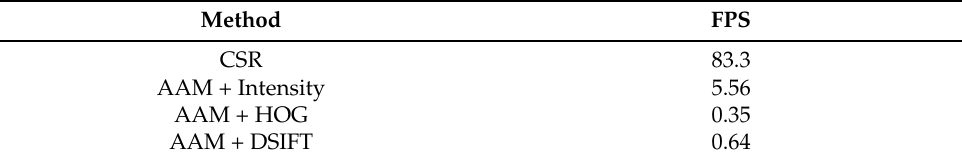
Figure 8. Examples of face alignment using Cascaded Shape Regression (CSR) and Intensity, Dense Scale Invariant Feature Transform (DSIFT), and Histogram of Oriented Gradients (HOG)-based Active Appearance Model (AAM). Table 2. The frames per second (FPS) of each method.